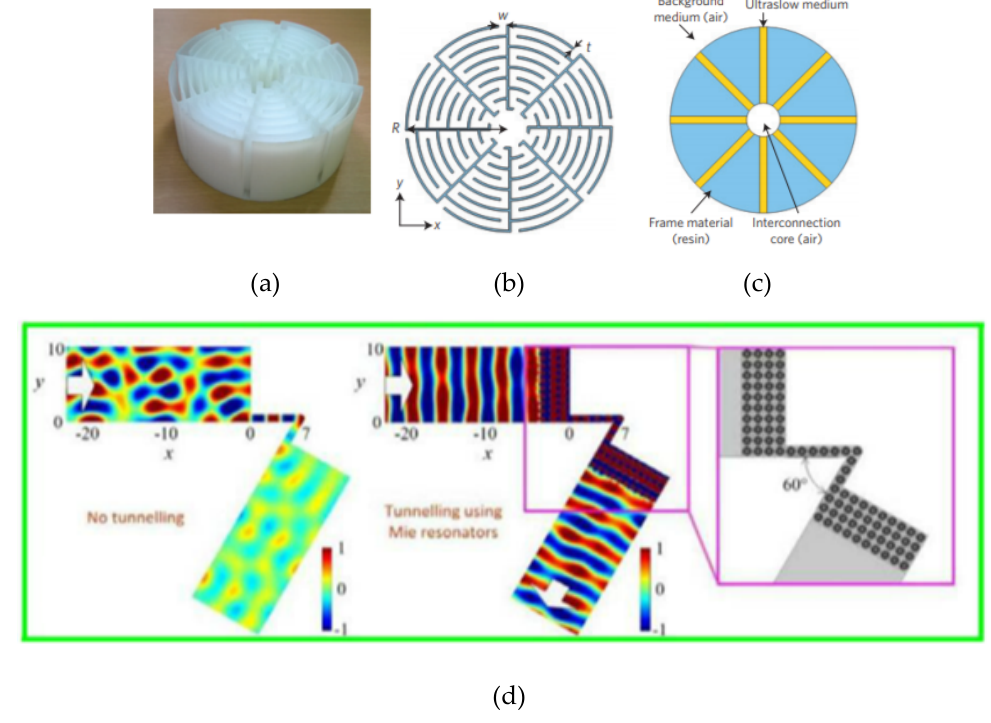
Figure 30. ( a – c ) Mie resonant unit with coiled space structure; ( d ) Meta-acoustic transmission of metamaterials [97].